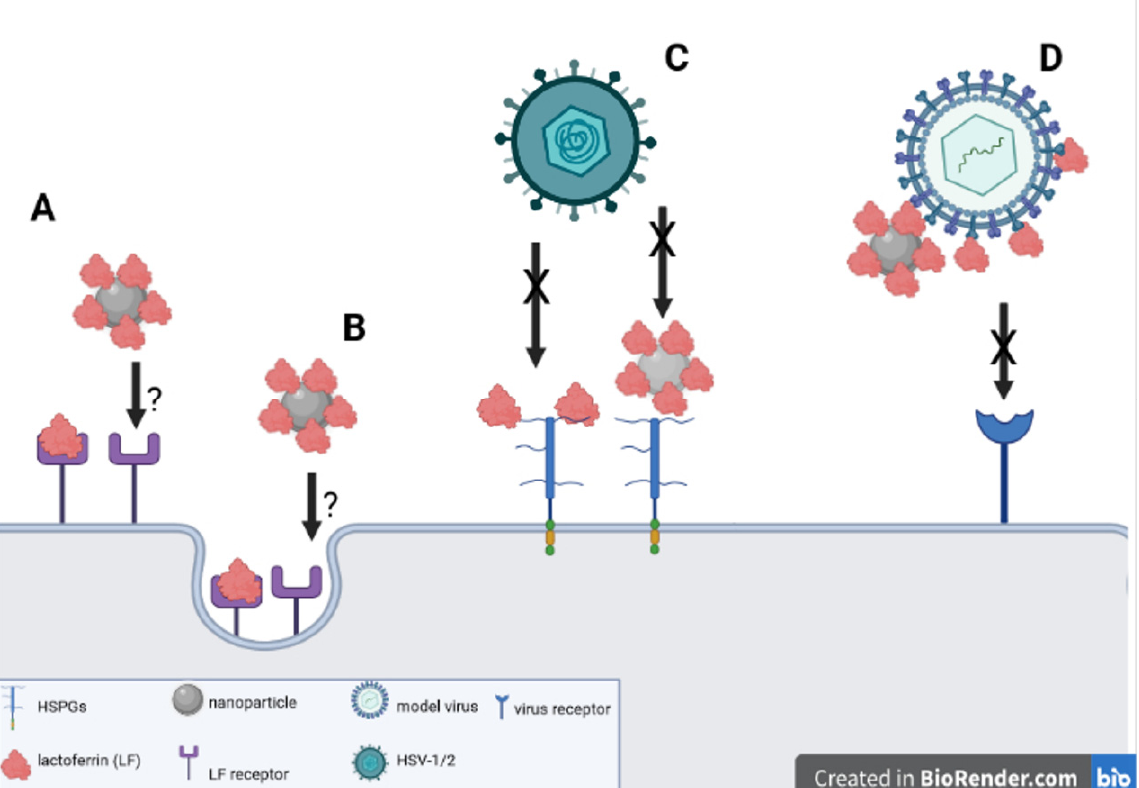
Figure 1. Schematic figure describing the possible mechanisms of antiviral actions by lactoferrin and lactoferrin-modified nanoparticles. ( A ) Lactoferrin can be internalized via endocytosis; the binding of lactoferrin-modified nanoparticles requires confirmation. ( B ) Endocytosis of lactoferrin-modified nanoparticles requires confirmation. ( C ) Lactoferrin or lactoferrin-modified nanoparticles can block HSV-1/2 infection through binding to heparan sulphate moieties present in the glycoproteins of the cell surface/extracellular matrix. ( D ) Lactoferrin or lactoferrin-modified nanoparticles can block the binding of a virus by binding to the virus attachment ligands (VALs), thus blocking the attachment of the virus to its specific receptor(s).